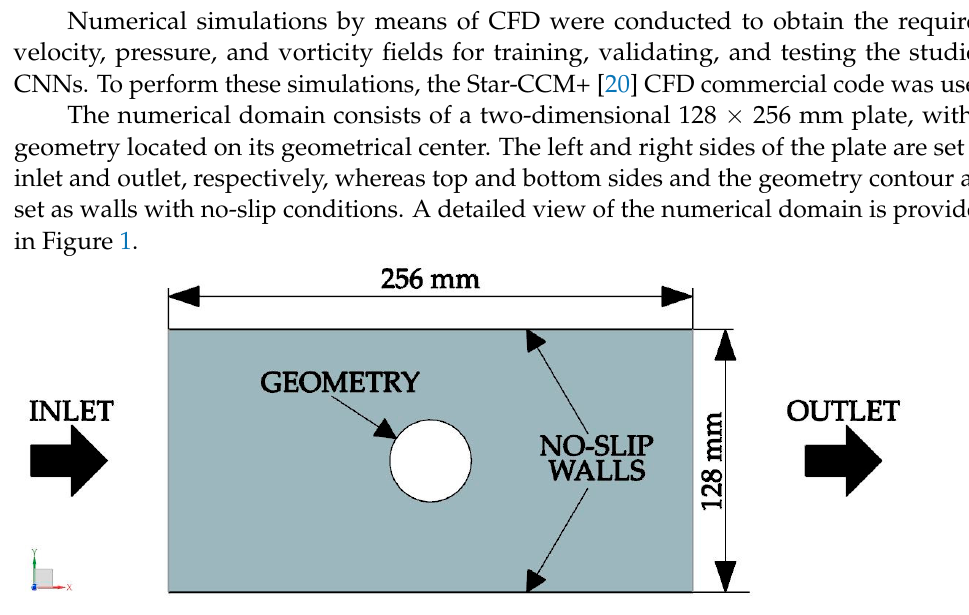
Figure 1. Numerical domain.